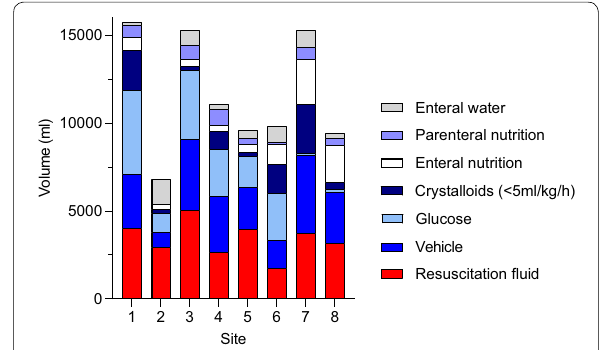
Fig. 2 Volume and type of fluids per site day 1–5. Data for type of fluid are presented as fraction of median volume. N number of